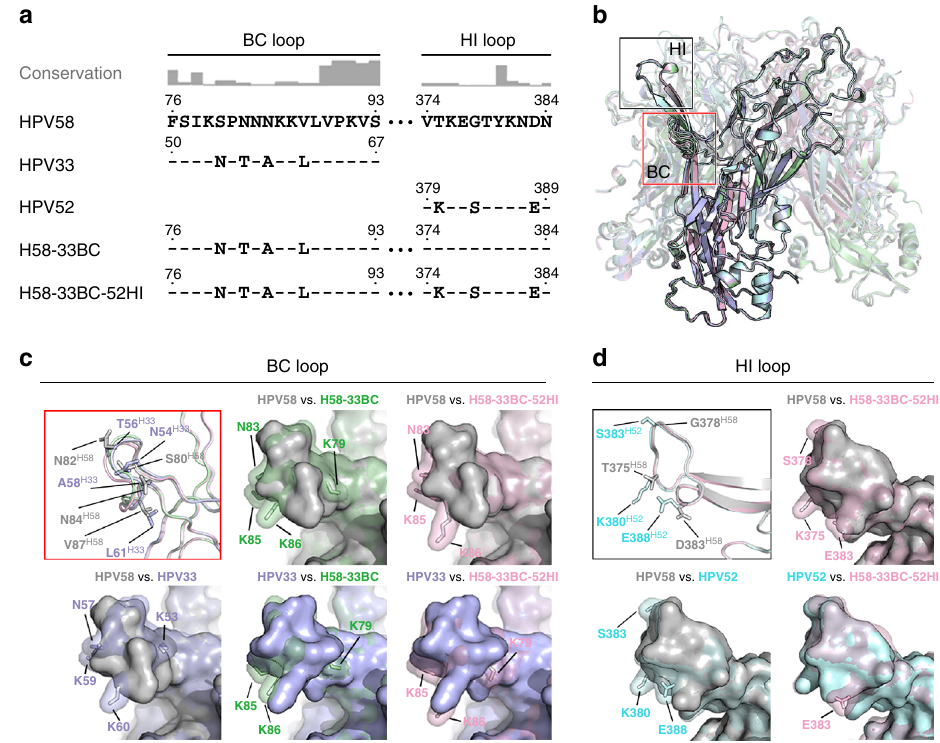
Fig. 7 Crystal structures of the chimeric pentamers. a The modi fi ed L1 sequence on the BC and HI loop(s) of the lead candidates of the double- and triple- type chimeric VLPs: H58-33BC and H58-33BC-52HI. The consensus is determined based on an alignment of L1 sequences from 20 different HPV serotypes (also see Supplementary Fig. 4). b A structural comparison of pentamers among HPV58 (gray), HPV33 (light blue), HPV52 (pale cyan), and the chimeric proteins H58-33BC (pale green) and H58-33BC-52HI (light pink). Loops BC and HI are boxed in red and black, respectively. c Structural comparisons of the BC loops of WT (HPV58 [gray], HPV33 [light blue]) and chimeric L1 proteins (H58-33BC [pale green], H58-33BC-52HI [pale pink]). Upper left: Ribbon display of superimposed main-chain carbon atoms. Side-chains of the different amino acids between HPV58 and HPV33 are labeled and shown as sticks. Upper middle, right and lower: Pairwise structural comparisons with surface display among HPV58, HPV33, H58-33BC and H58-33BC- 52HI. d Structural comparisons of HI loops of WT (HPV58 [gray], HPV52 [pale cyan]) and the chimeric L1 protein (H58-33BC-52HI [light pink]). Upper left: Ribbon display of superimposed main-chain carbon atoms. Side-chains of the different amino acids between HPV58 and HPV52 are labeled and shown as sticks. Upper right and lower: Pairwise structural comparisons with surface display among HPV58, HPV52 and H58-33BC-52HI. For presentation clarity, the surface of the chimera in the pairwise surface comparisons in c , d is shown with 50% transparency and embracing the model rendered in stick mode; the surface of the wild-type model is shown with full